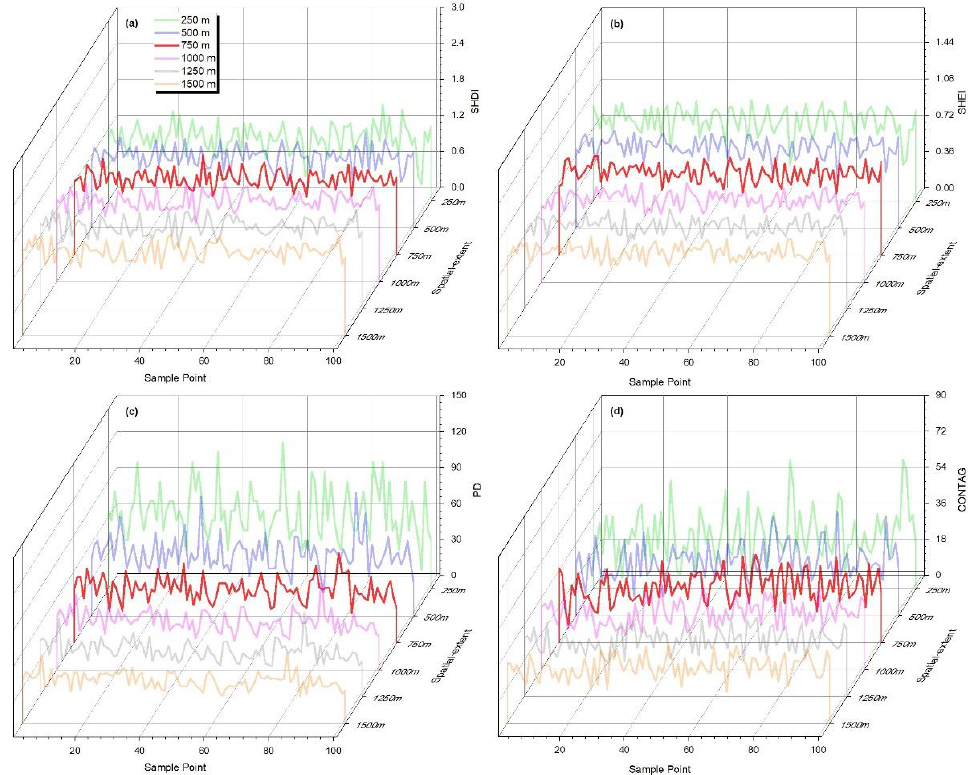
Figure 4. The landscape metrics fluctuation curves of the sample points at different spatial-extents: ( a ) SHDI, ( b ) SHEI, ( c ) PD, and ( d ) CONTAG.